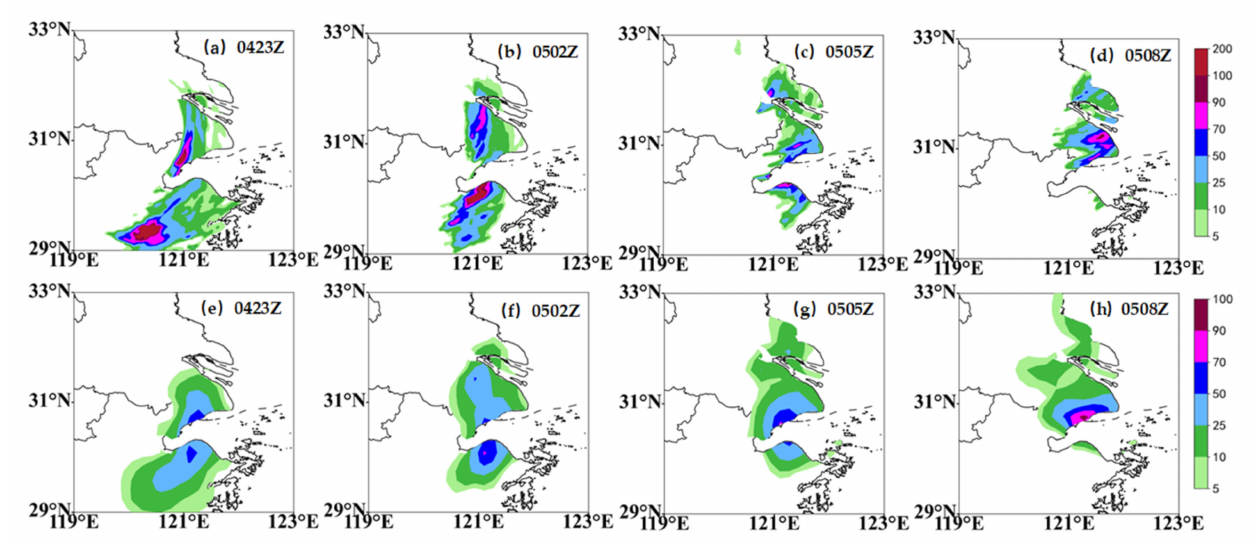
Figure 6. Cumulative 3-h rainfall from 20:00 BT on 4 August to 08:00 BT 5 August 2020, simulation of 3 km domain ( a – d : unit: mm) and the observed 3-h rainfall of the corresponding period of time ( e – h : unit: mm). ( a , e ) 23:00 BT 4, ( b , f ) 02:00 BT 5, ( c , g ) 05:00 BT 5, ( d , h ) 08:00 BT